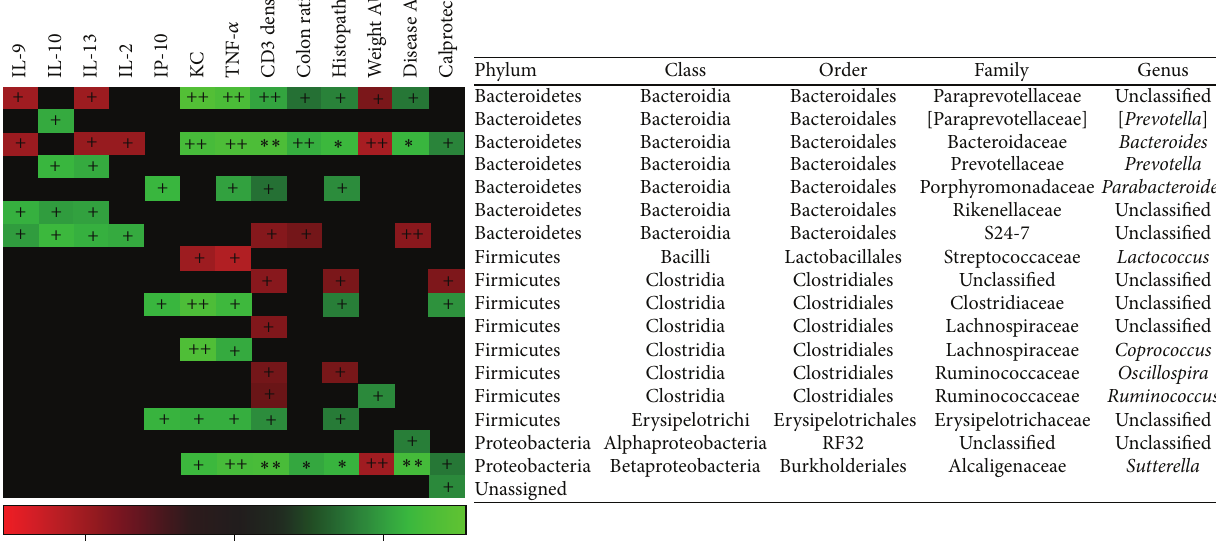
correlates positively with IL-10 levels. In the DSS model